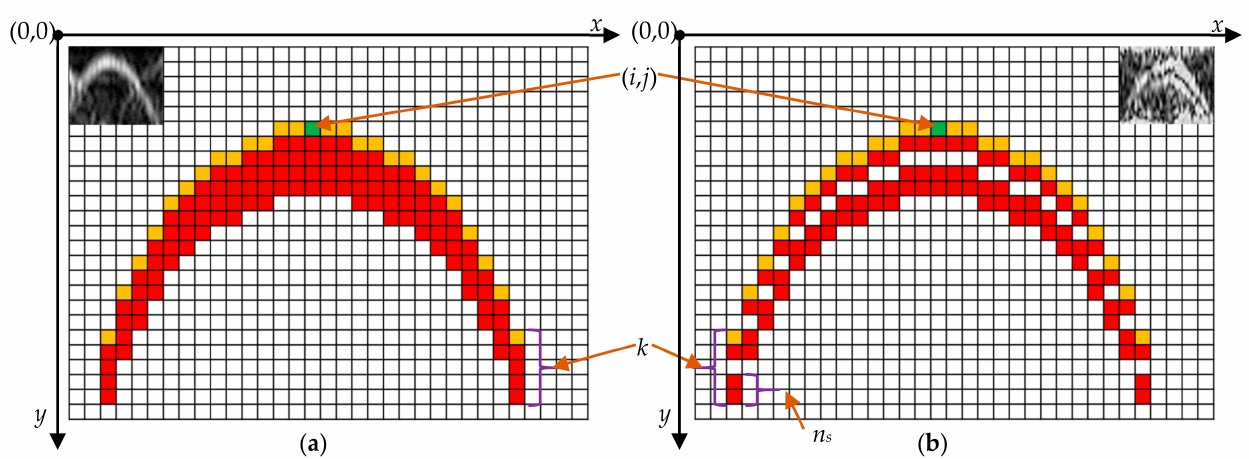
Figure 10. Examples of pipeline shape in the pre-processed SBP image. ( a ) Pipeline diameter is less than SBP resolution; ( b ) pipeline diameter is larger than the SBP resolution. k is the pixel index relative to the first pipeline echo in each column of the image. The empty spaces in the pipeline image are the gaps between echoes from the upper and lower surfaces of the pipeline. n s is the number of the pixels produced by the echo signal from the